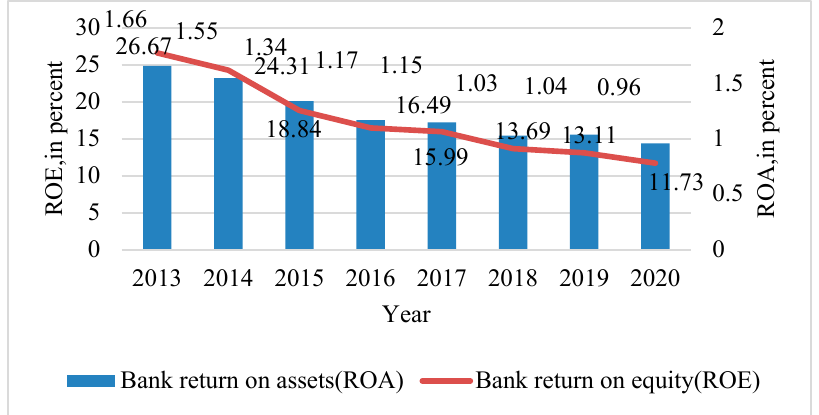
Figure 1. Evolution of average ROA and ROE in China’s banking sector over the period 2013–2020, Source: author’s preparation. (h tt ps://www.theglobaleconomy.com/China/) accessed on 28 Decem- ber 2022. Notes: abscissa axis − years, (left) ordinate axis − average return on assets of China’s banking system; (right) ordinate axis − average return on equity of China’s banking system.